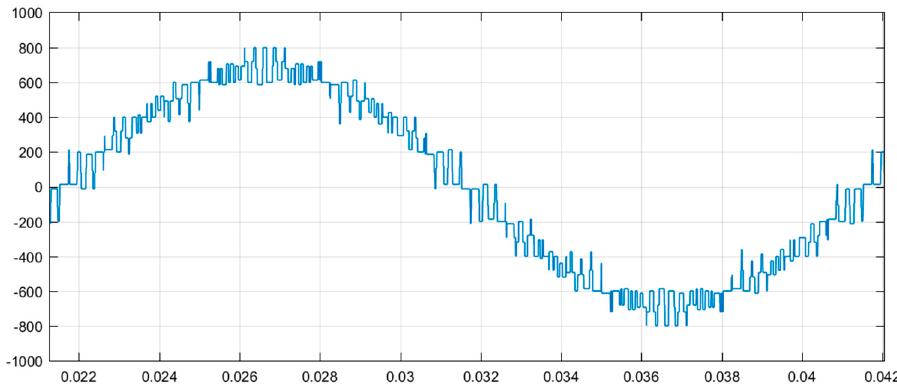
Figure 19. Three-phase four H-bridge CHB line voltage for PS PWM and best switching of non-equal sources.